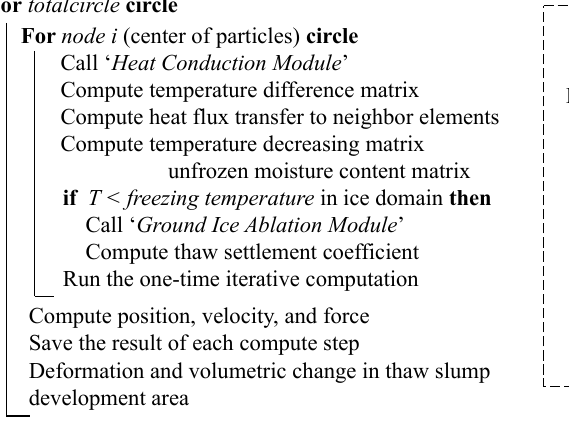
Figure 7. Flow chart and framework of DEM-FDM in the K1129W thaw slump. Table 2. Physical and thermal parameters of the K1129W thaw slump